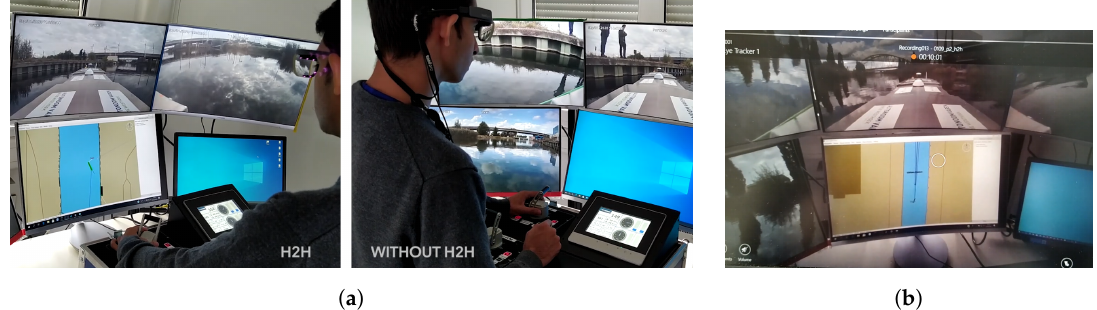
Figure 17. Single-handed sailing with the USV and I-SCC system on a canal (Leuven): ( a ) Video S2: docking manoeuvres from a participant (left) with the H2H-application, and (right) without the H2H application; ( b ) Video S3: tracking of the eye movements of a participant during the 180° turn of a straight sailing